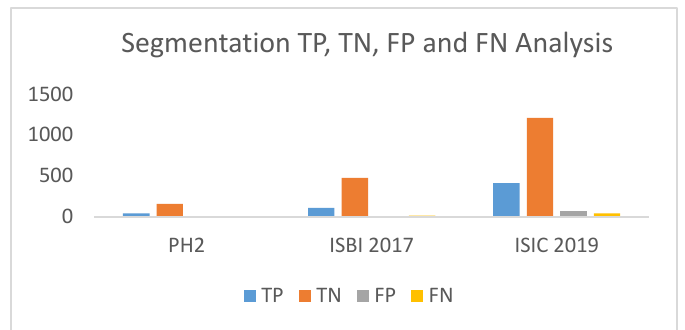
Figure 16. True positive (TP), true negative (TN), false positive (FP), false negative (FN) analysis of the proposed segmentation method.